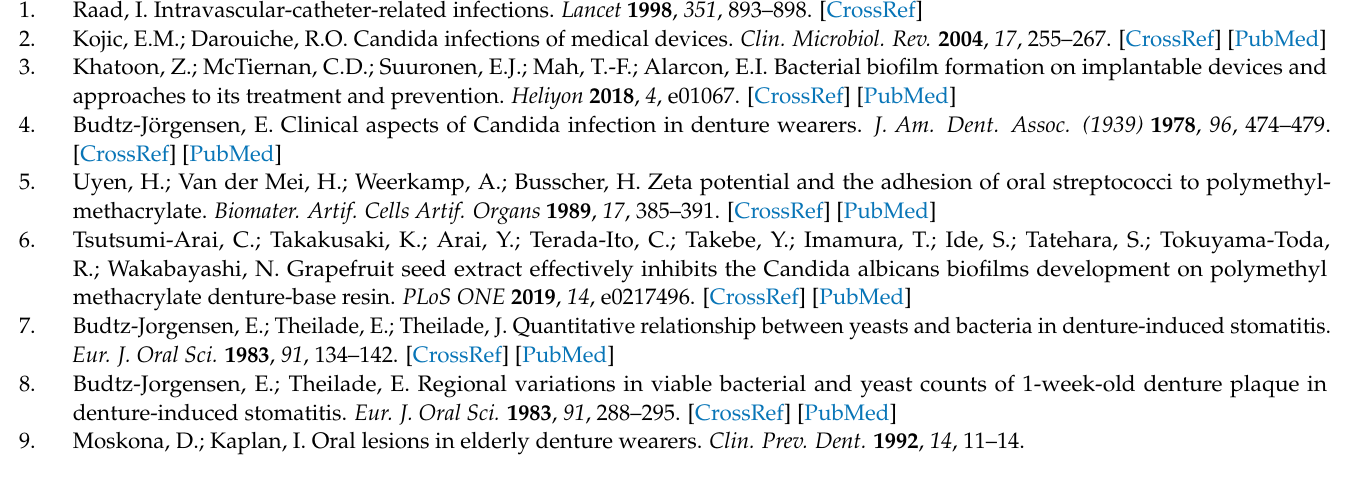
Figure S2: Effects of artificial saliva and/ or CPC on 4 strains of C. albicans on